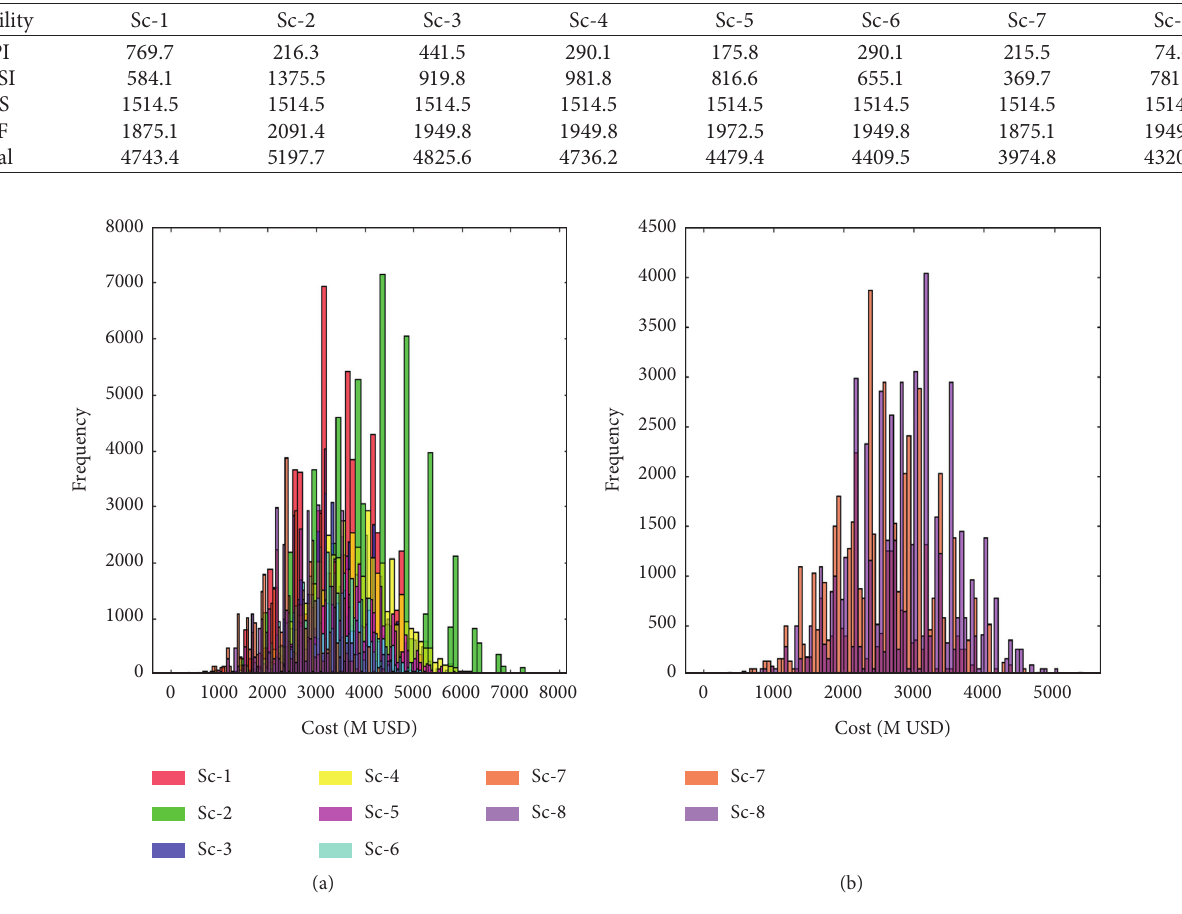
Figure 9: MATLAB simulations for case (a) and (b).